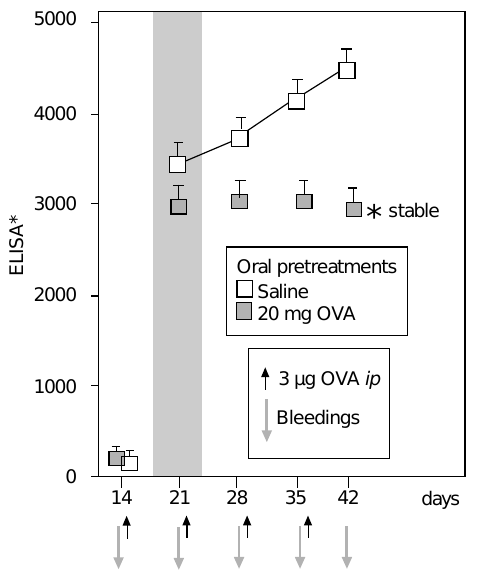
42Figure 5 - Stabilization of serum antibody responses by nasal treatment with antigen. B6D2F1 mice were pretreated by nasal instillation for 5 consecutive days with either a microdrop (20 ml) of saline (open squares) or saline containing variable doses of OVA per exposure. Pretreatments ended 7 days before primary immunization with 10 µg OVA + 1 mg Al(OH) 3 ip ; 14 days later, a series of 4 weekly challenges with 3 µg soluble OVA was initiated. Immediately before each booster the mice were bled for measurement of antibod- ies by ELISA. Asterisks indicate significant differences between control and experimental groups.